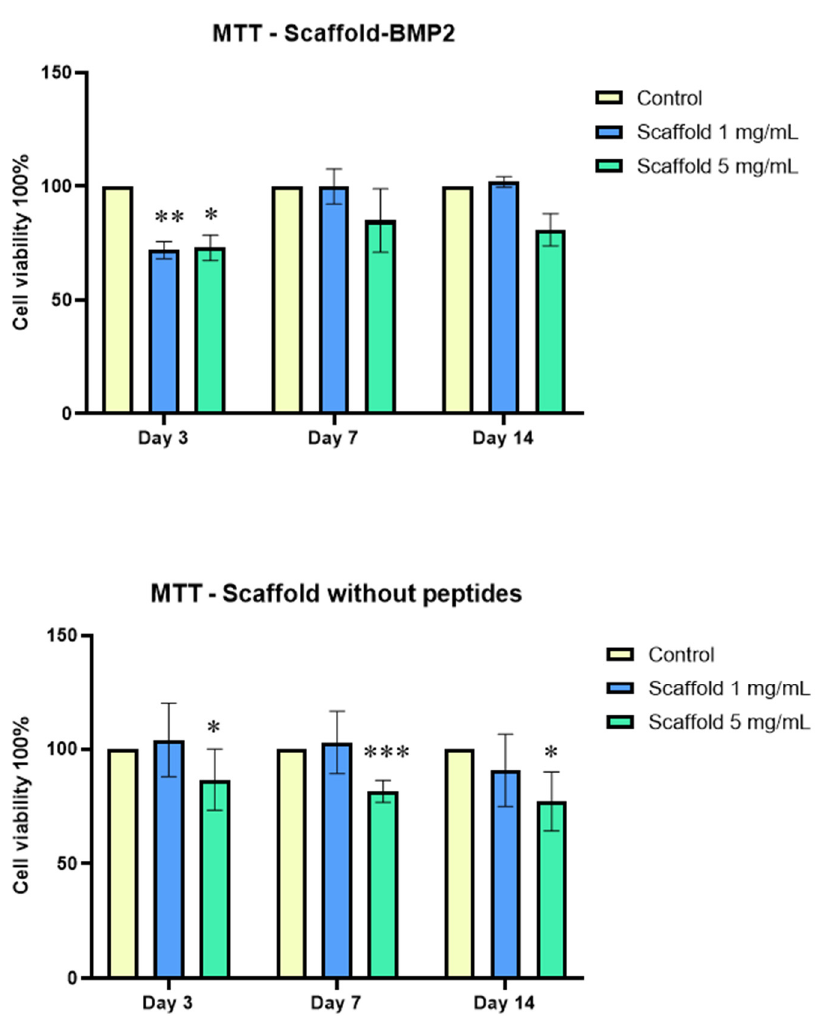
Figure 8. Evaluation of the viability of human dental pulp stem/stromal cells (hDPSCs) on different concentrations of scaffold-BMP-2 or scaffold without peptides by MTT assay. The assay was performed at 3 time points (3, 7, and 14 days of culture). The optical density was measured at 570 nm with a reference filter at 630 nm. “Control”: hDPSCs in full α -MEM ( α -MEM supplemented with 15% v / v fetal bovine serum, 100 units/mL penicillin, 100 µ g/mL streptomycin, and 100 mM L-ascorbic acid). The data are presented as mean ± SD values of % cell viability. Asterisks (*), (**), and (***) indicate statistically significant differences ( p ≤ 0.05, p ≤ 0.01, and p ≤ 0.001, respectively) compared to control cells.